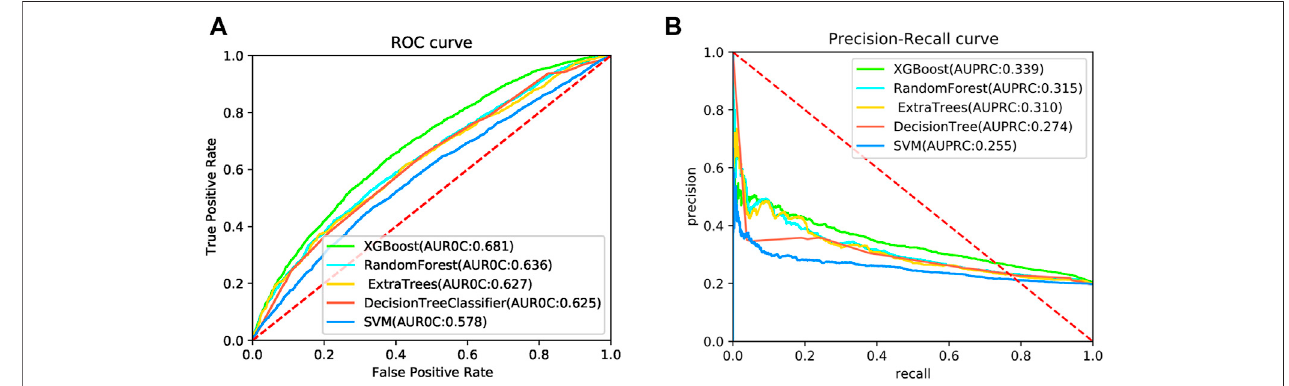
FIGURE 5 | The ROC curves (A) and precision-recall curves (B) for 5 algorithms on the independent test.